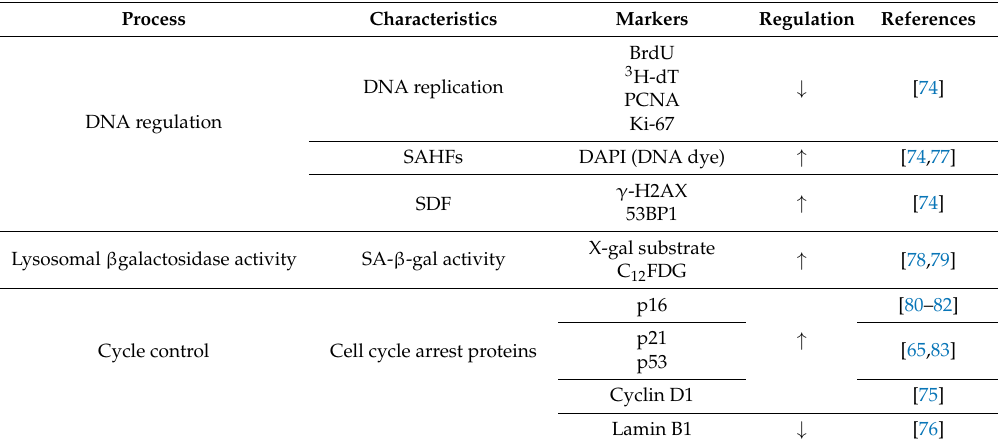
Table 1. Senescence cell